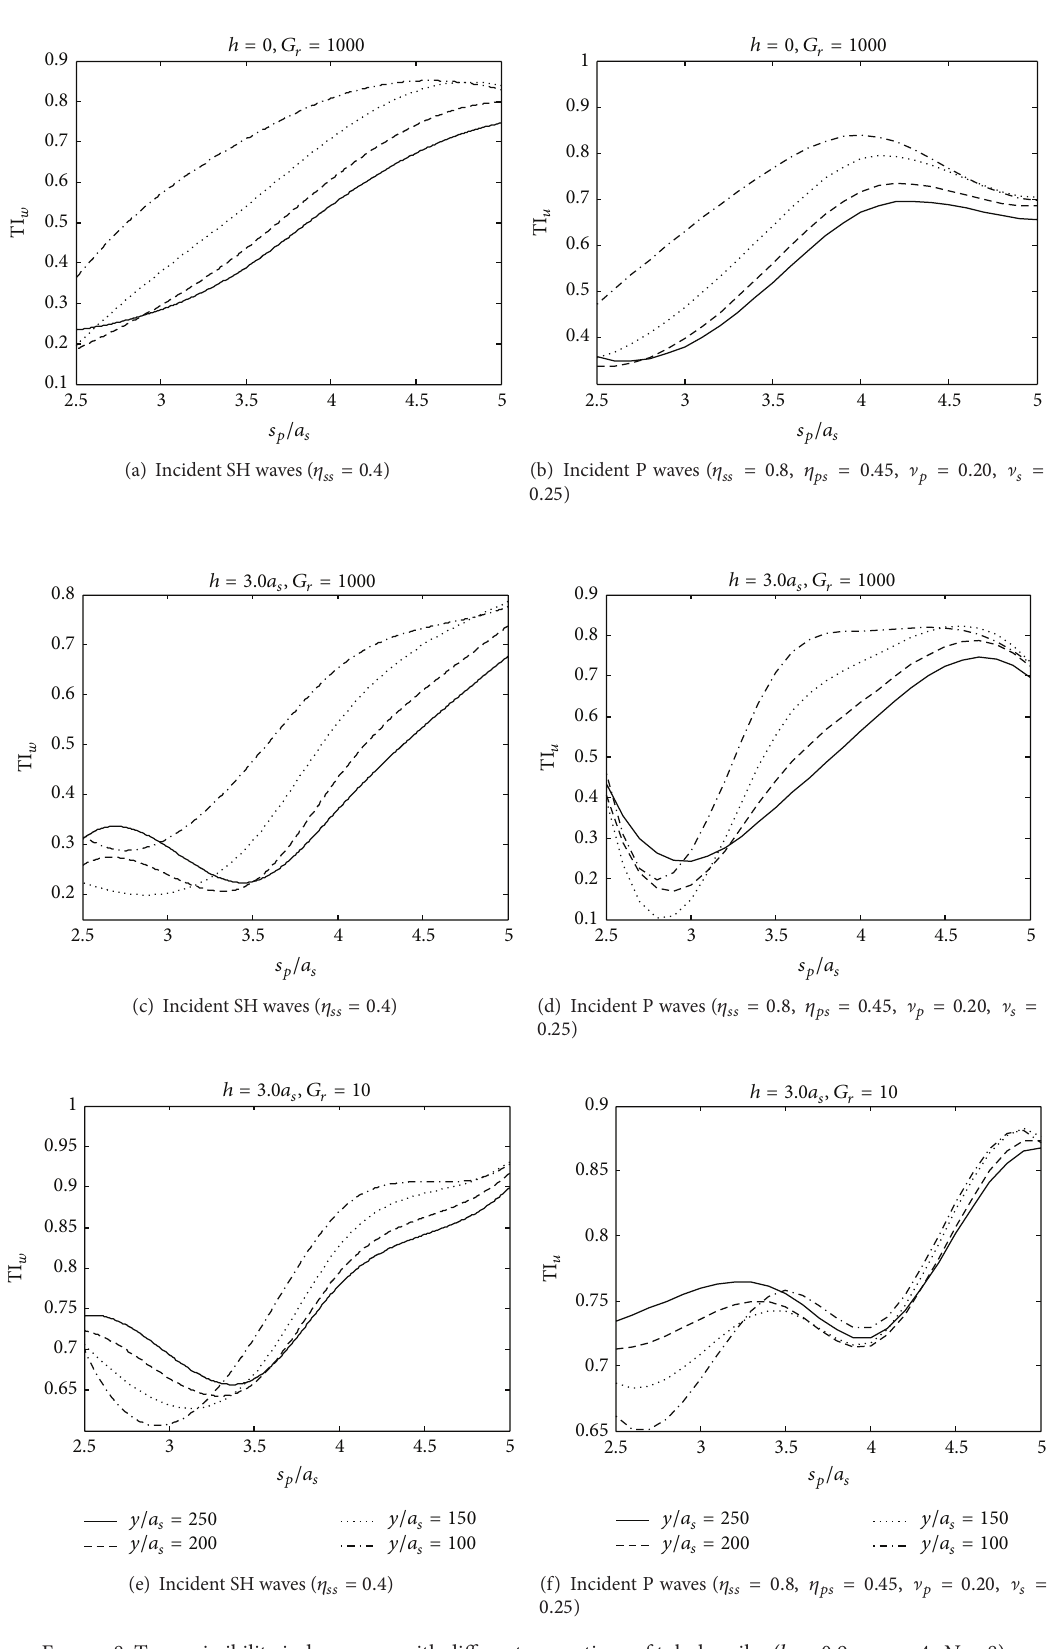
Figure 8: Transmissibility index curves with different separations of tubular piles ( 𝑏 𝑠 = 0.9𝑎 𝑠 , 𝑚 = 4 , 𝑁 = 8